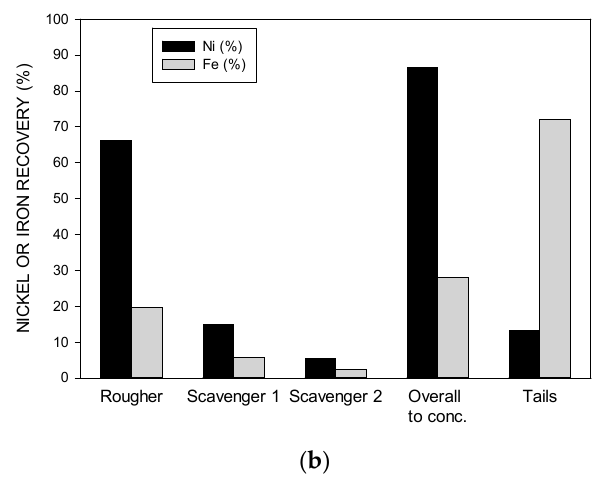
Figure 17. ( a ) Nickel and iron grades in the concentrates and tails for the rotary kiln tests; ( b ) Nickel and iron recoveries in the concentrates and tails for the rotary kiln tests.